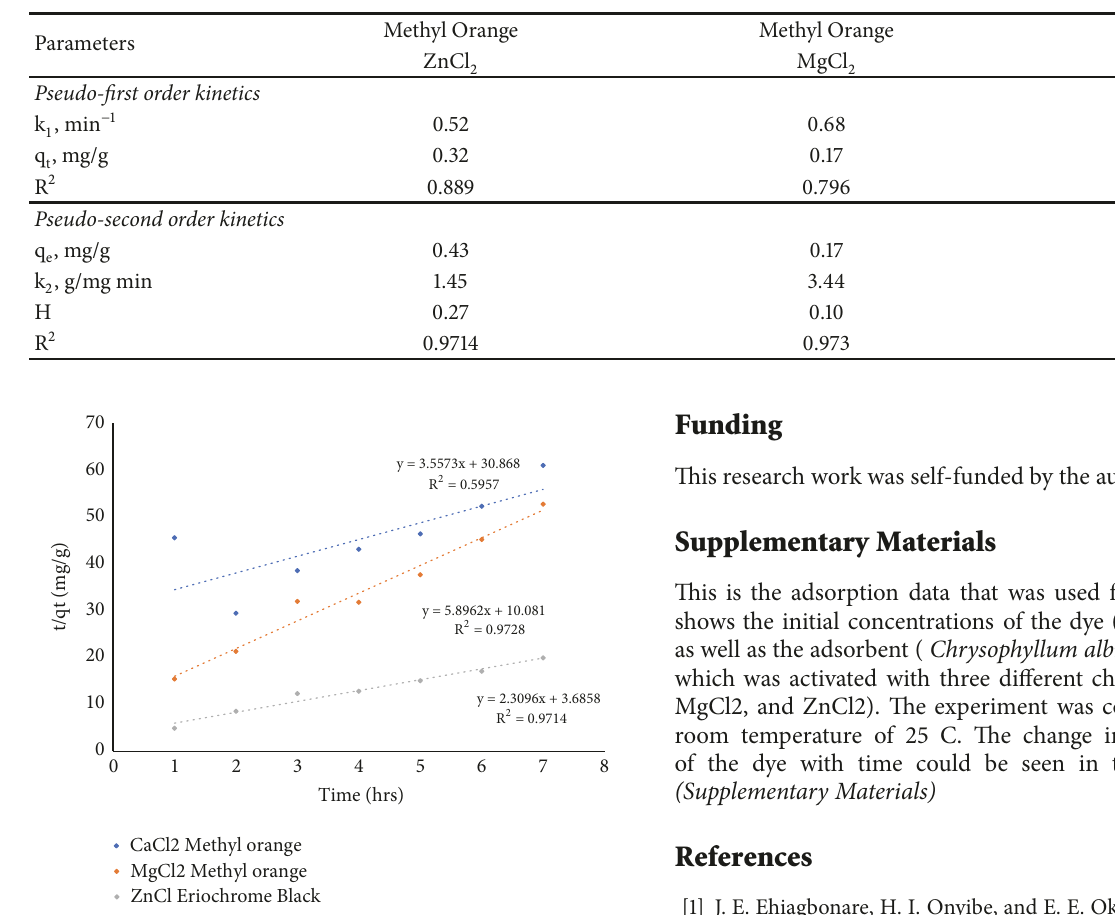
Figure 4: Pseudo-second-order adsorption kinetics of the